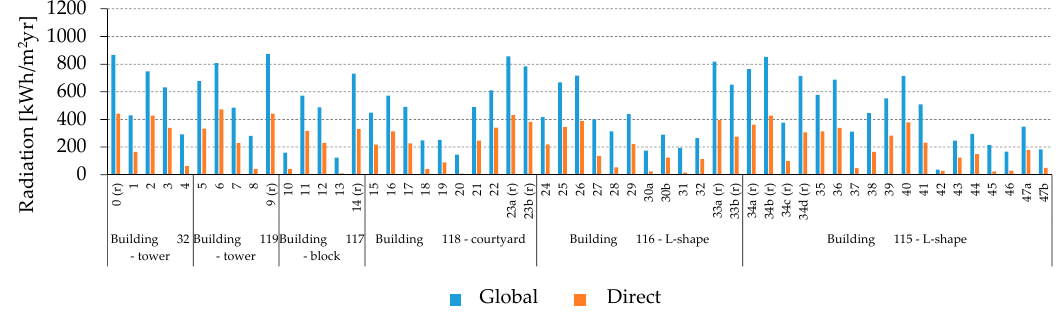
Figure 25. Average irradiation on the roofs (r) and façades in the critical area for feasibility study II.